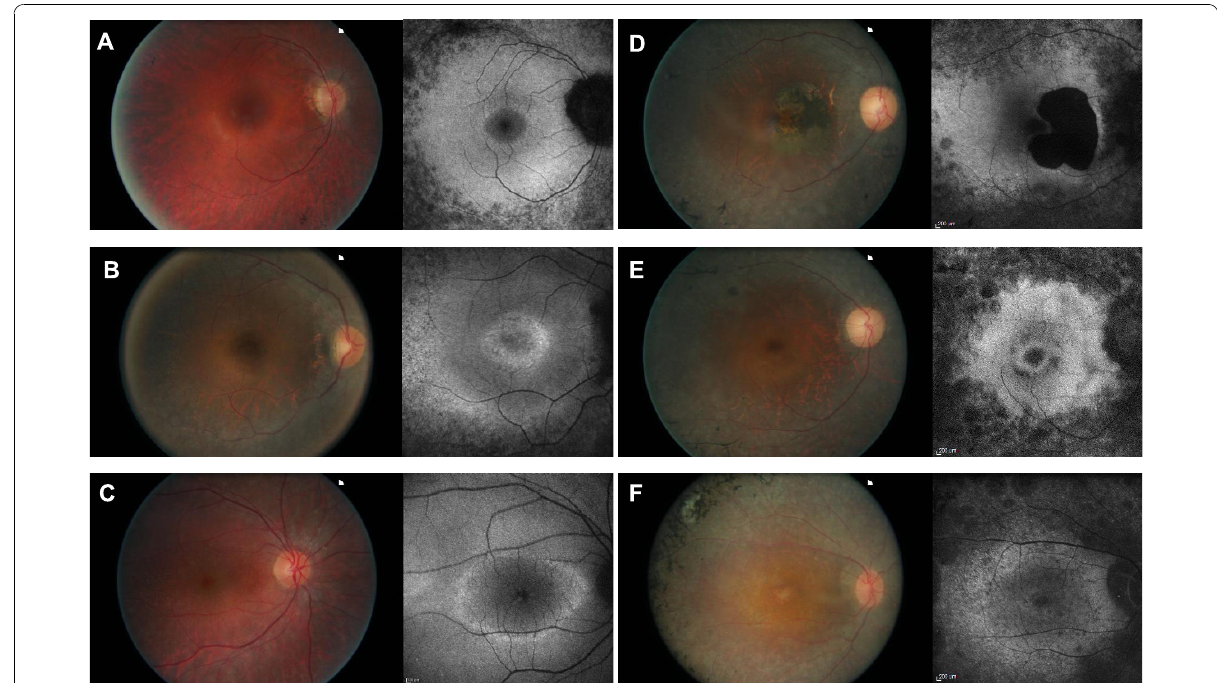
Figure 2 Color fundus photograph and autofluorescence imaging of the right eye for each index patient: A: CIC0398; B: CIC00607; C: CIC00034; D: CIC01171; E CIC00140; F: CIC03777